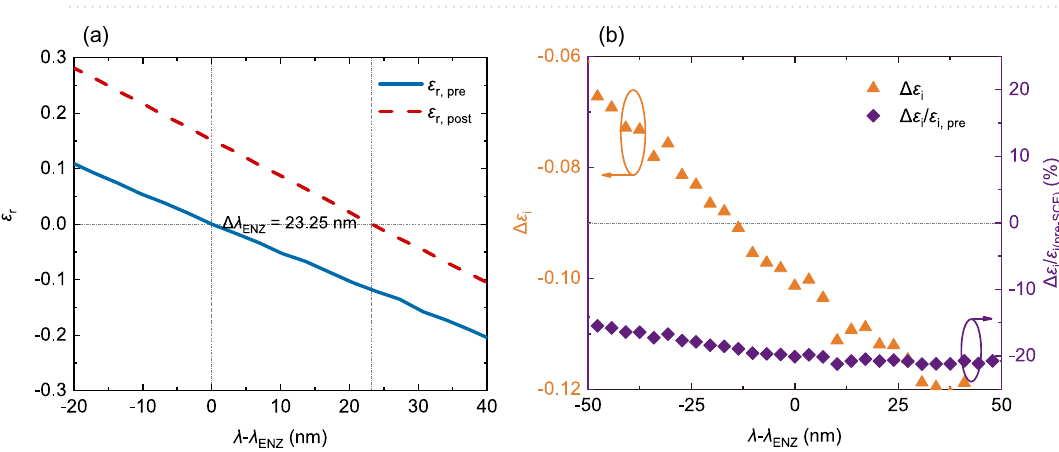
Figure 2. Linear ENZ properties manipulated and improved by SCF. ( a ) The change in (cid:31) ENZ after SCF oxidation process. The solid line represents the real part of permittivity ε r before the SCF processing, and the dashed line denotes that after SCF. ( b ) The change in loss within the ENZ region. The triangles represent the changes of imaginary parts �ε i = ε i,post − ε i,pre (refer to the left y -axis), and the diamonds denote the proportions of changes compared with the ε i values before SCF (refer to the right y